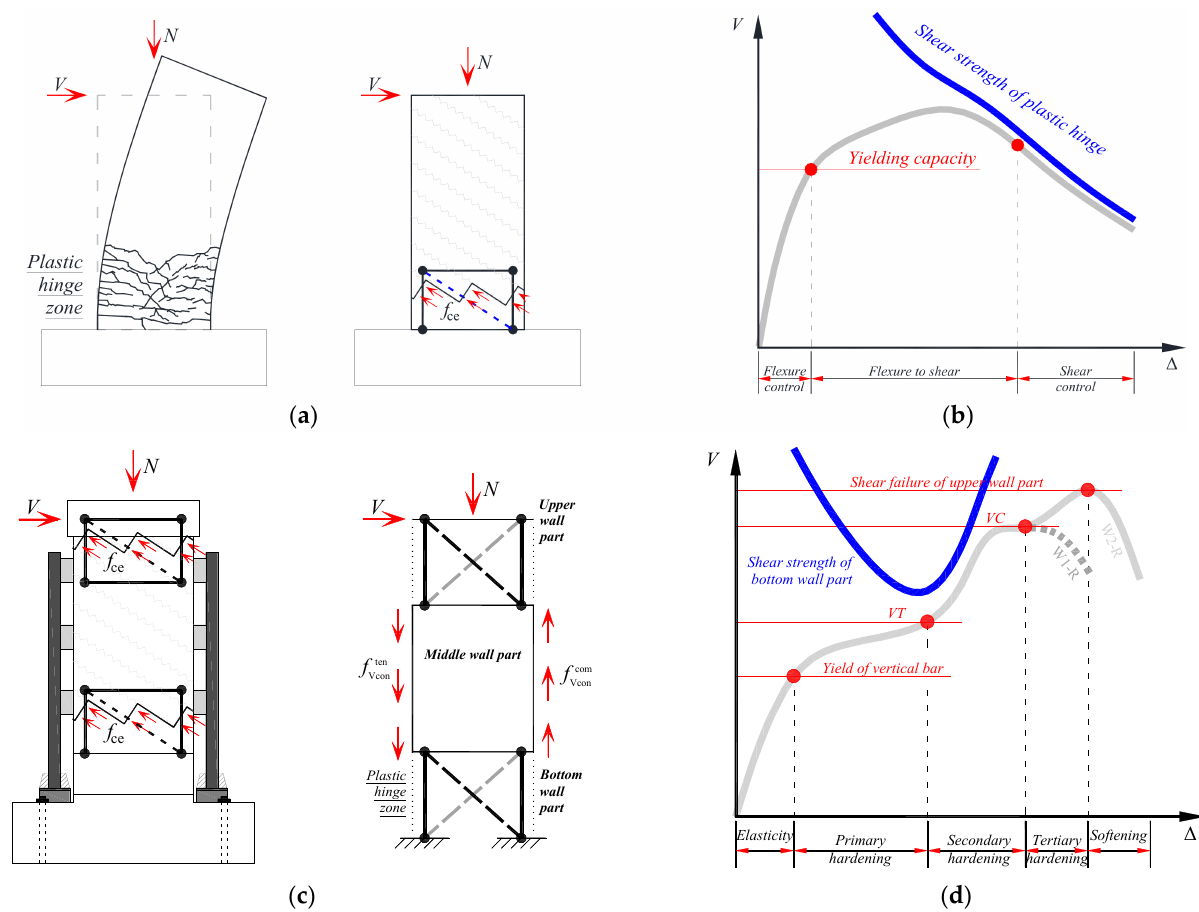
Figure 23. Conceptual analysis shear walls. ( a ) Load path and truss mechanism of slender cast-in- place wall; ( b ) Schematic of load–displacement relationship of slender wall [32,33]; ( c ) Load path and truss mechanism of PC wall; ( d ) Schematic of load–displacement relationship of PC wall.